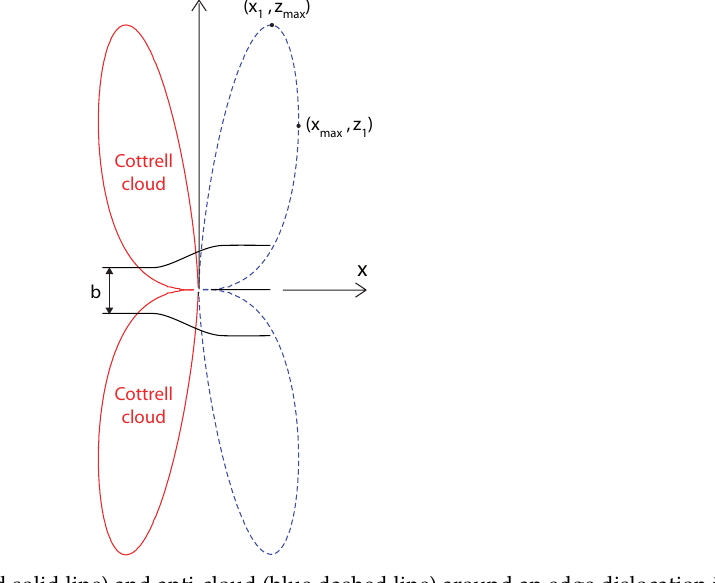
Figure 4. Cottrell cloud (red solid line) and anti-cloud (blue dashed line) around an edge dislocation in a smectic A LC (from Ref.